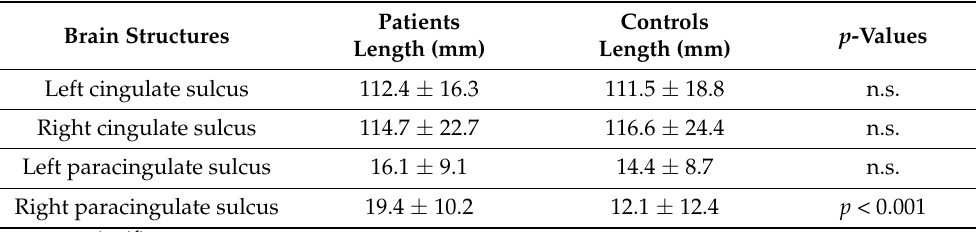
Table 4. Left and right CS and PCS without parcellation overall length differences between schizophre- nia patients and control groups. The data are presented as mean values ± SD in mm. Statistical significance was calculated by t -test for groups.